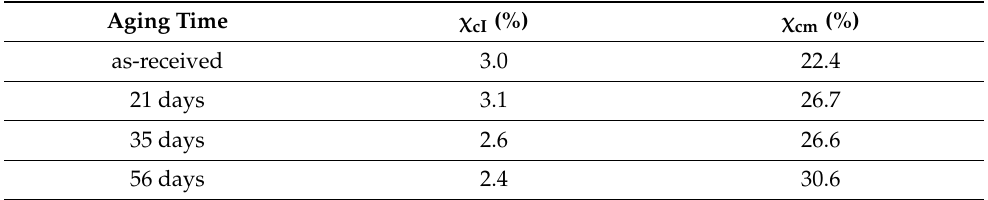
Table 3. Degree of crystallinity formed during primary ( χ cm ) and secondary ( χ cI ) crystallization.